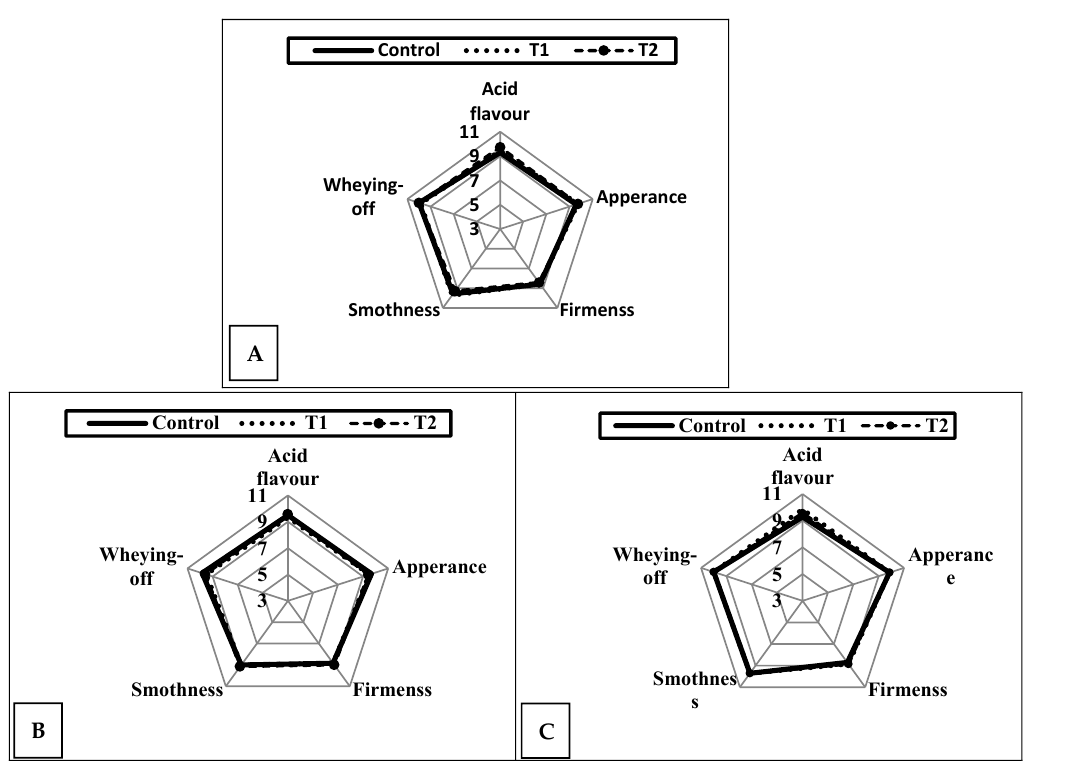
Figure 9. Effect of chromium (CrPic) on the sensory properties of fortified yoghurt when fresh ( A ) and after cold storage for a week ( B ) and 2 weeks ( C ). Control: without Cr (CrPi), T1: with 0.25 ppm Cr (CrPi), T2: fortified with 0.5 ppm Cr (CrPi). Data are shown as the mean of three replicates.